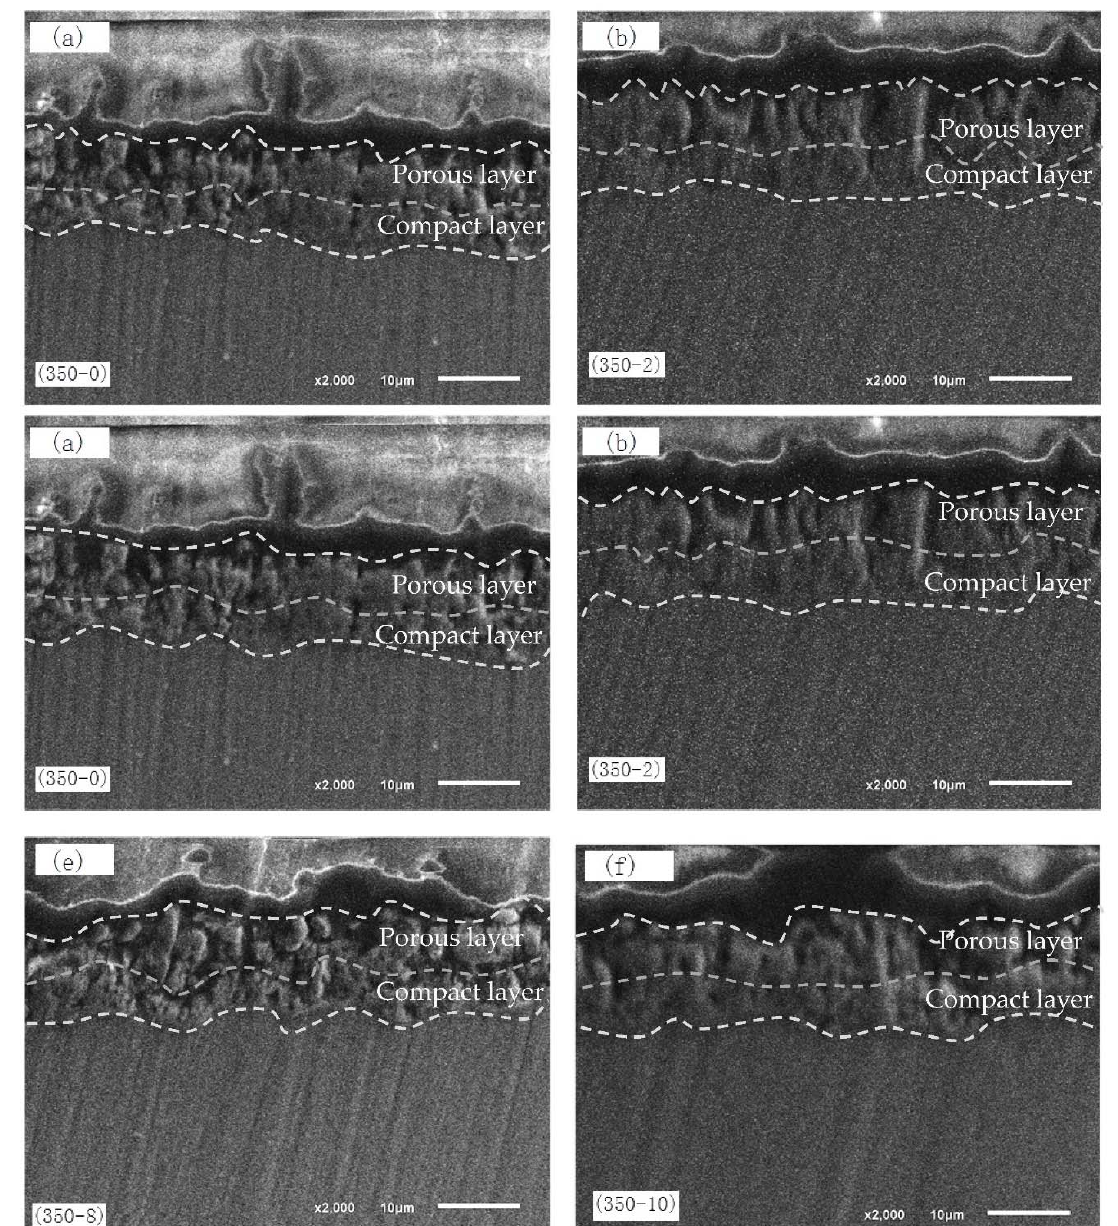
Figure 2. Cross-section morphology of MAO coatings formed at pretreatment with different concentrations of Nd(NO 3 ) 3 solution: ( a ) 350–0, ( b ) 350–2, ( c ) 350–4, ( d ) 350–6, ( e ) 350–8, and ( f ) 350–10.